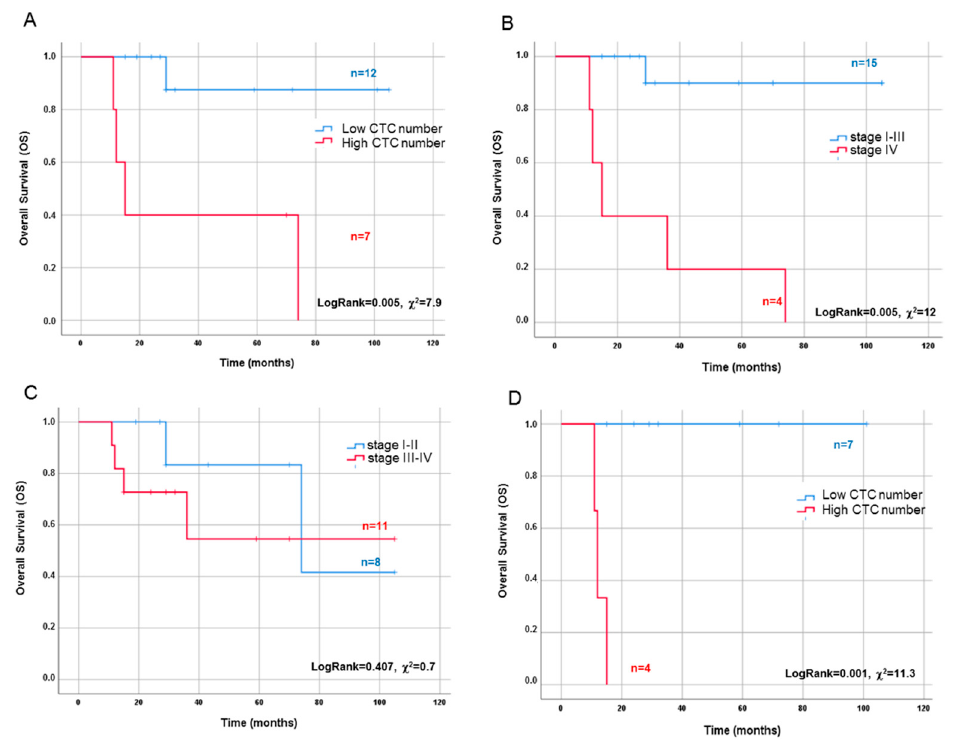
Figure 5. Comparison between the overall survival predictive value of CTC count and stage in ACC patients. Overall survival (OS) Kaplan–Meier curves evaluated in the whole cohort of patients according to stratification in low / high classes of CTC count in PreS samples (cut o ff value: 9 cells / 3 mL) ( A ), in metastatic vs. non-metastatic classes (stage IV vs. I–III) ( B ), and in aggressive vs. non-aggressive classes (stage III–IV vs. I–II) ( C ). Stratification of aggressive stage III–IV patients according to low / high classes of CTC count in PreS samples ( D ). Log rank and χ 2 values are indicated as well as the number of patients in each class.